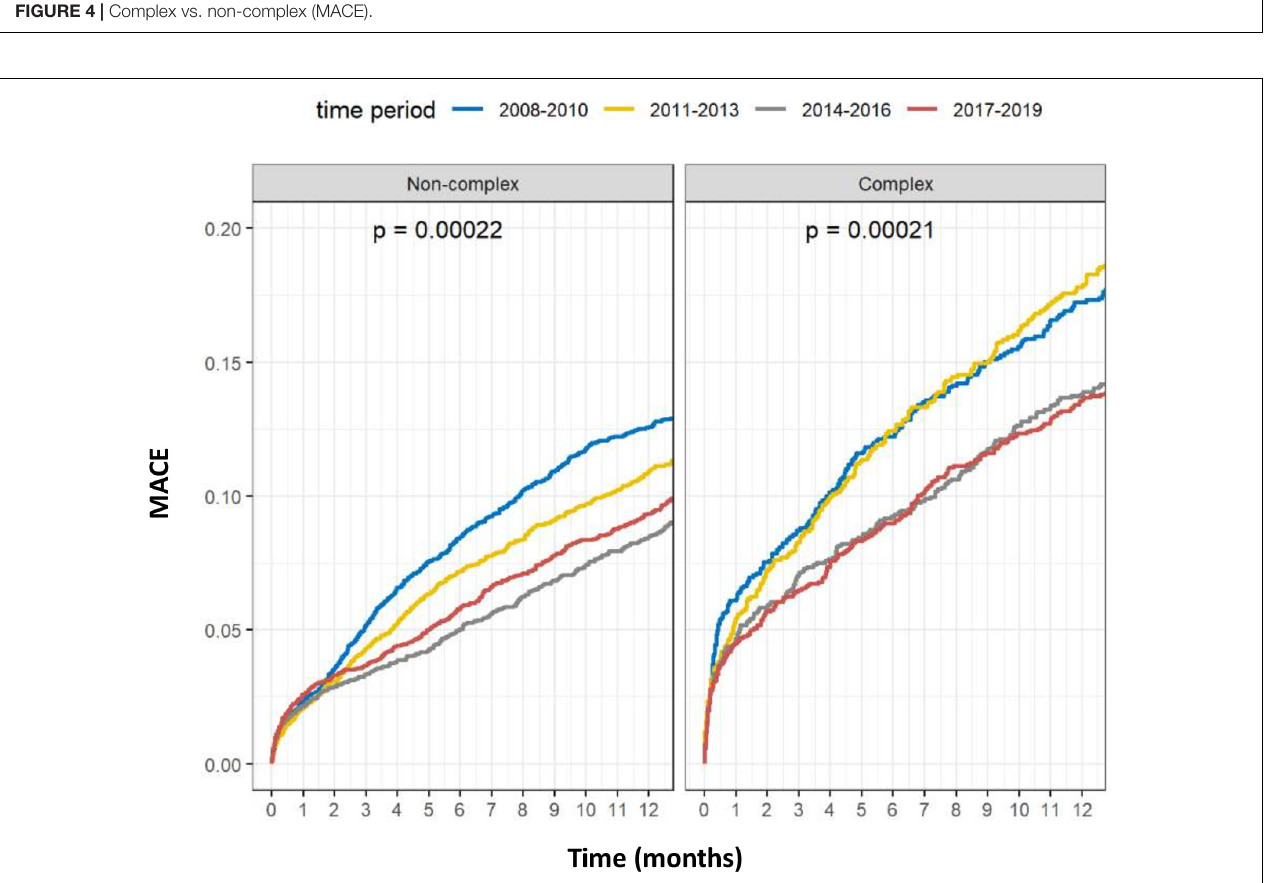
FIGURE 4 | Complex vs. non-complex (MACE).